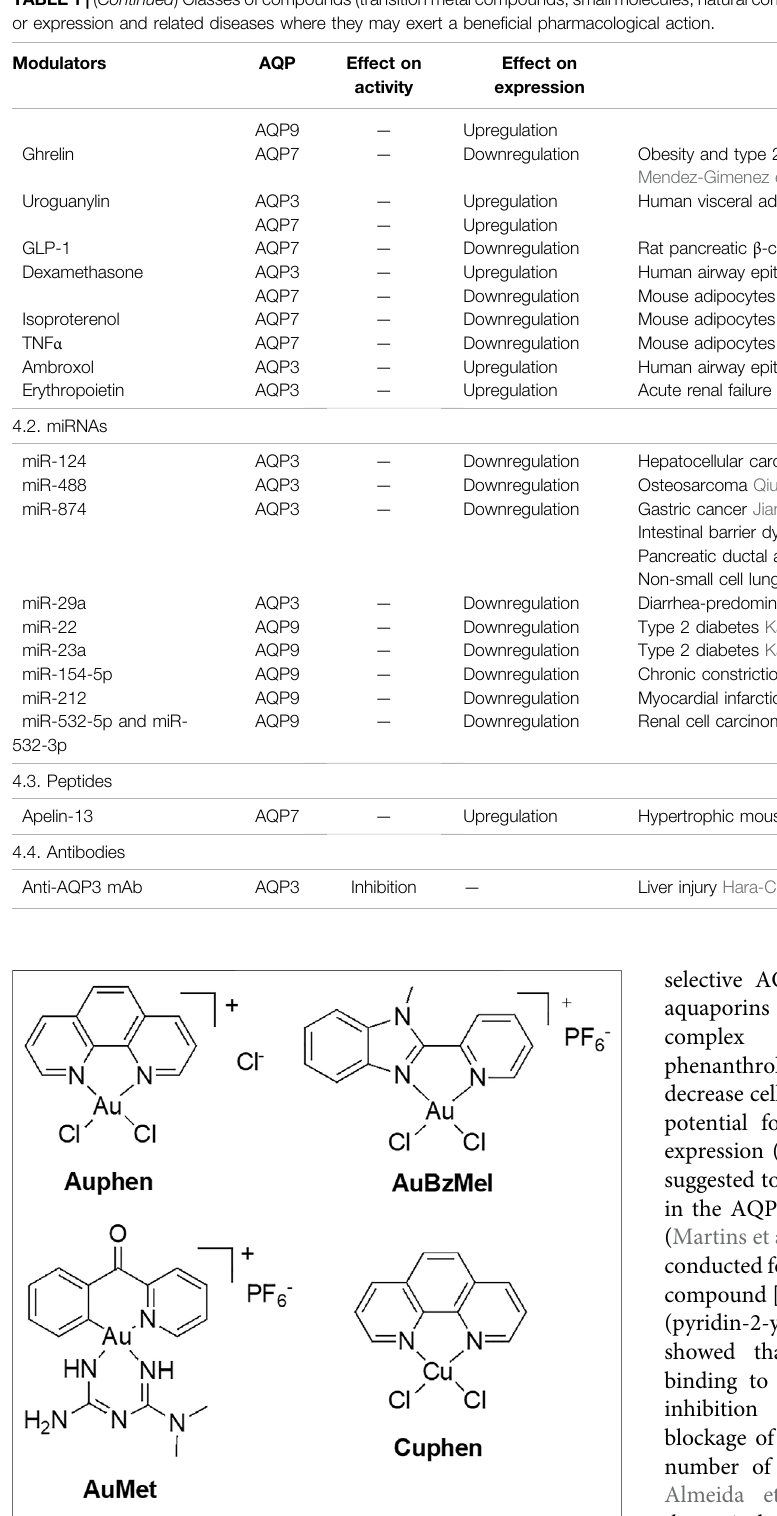
FIGURE 5 | Au(III) and Cu(II) compounds as aquaglyceroporins